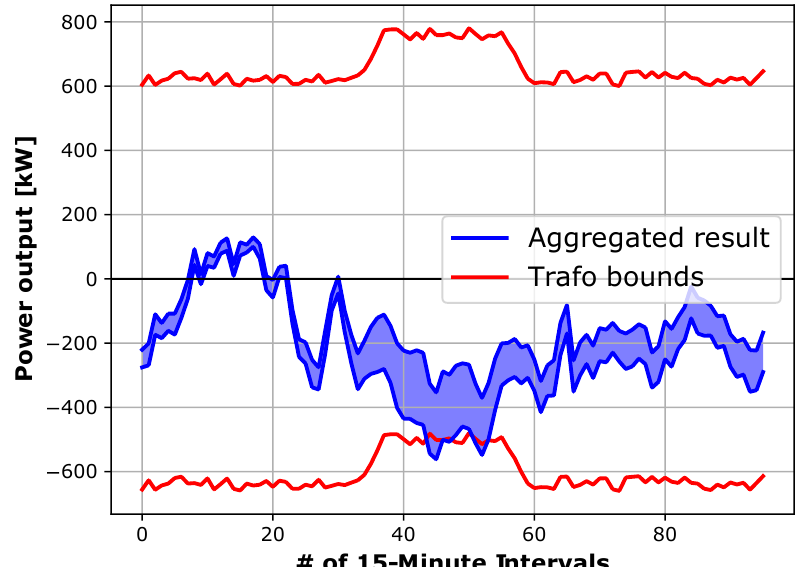
Figure 8. Uncertainty of the aggregated schedule in comparison with load limits imposed by the